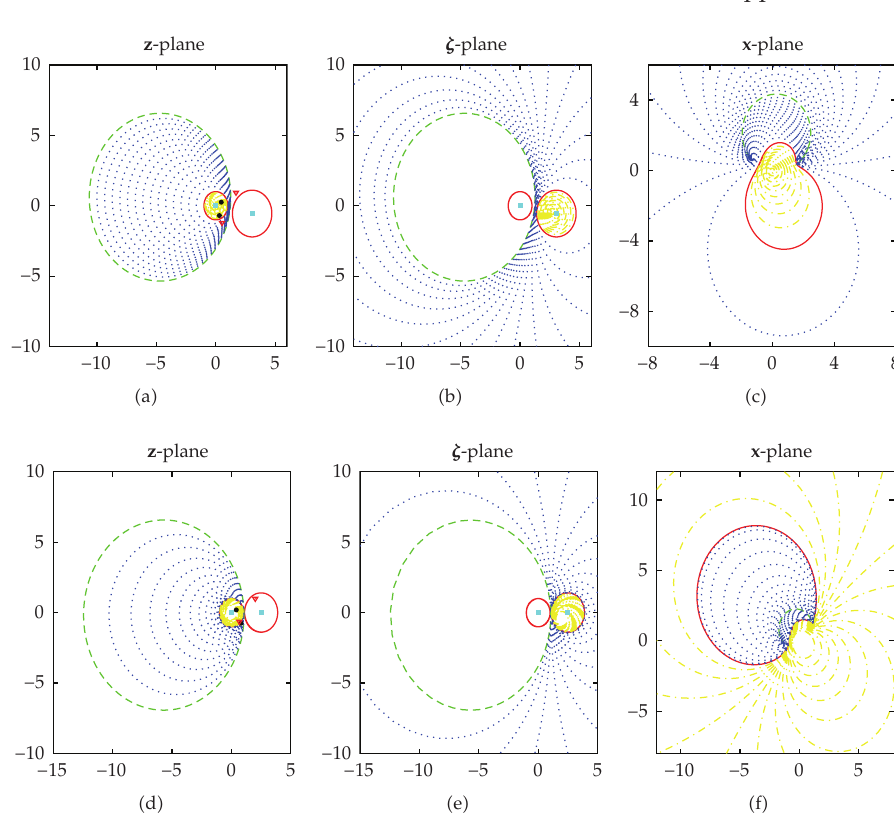
Figure 5: As in Figure 3, but for vortices of kind (cid:2) 3 , 1 (cid:3) (cid:2) first row, with a 1 (cid:7) 1, a 2 (cid:7) 0 . 5 − 0 . 1 i , z 1 (cid:7) 0 . 3 − 0 . 7 i , and z 2 (cid:7) 0 . 45 (cid:6) 0 . 25 i (cid:3) and of kind (cid:2) 3 , 2 (cid:3) (cid:2) second row, with a 1 (cid:7) 1, a 2 (cid:7) 0 . 5 − 0 . 1 i , z 1 (cid:7) 0 . 80 − 0 . 75 i , and z 2 (cid:7) 0 . 4 (cid:6) 0 . 2 i (cid:3) .